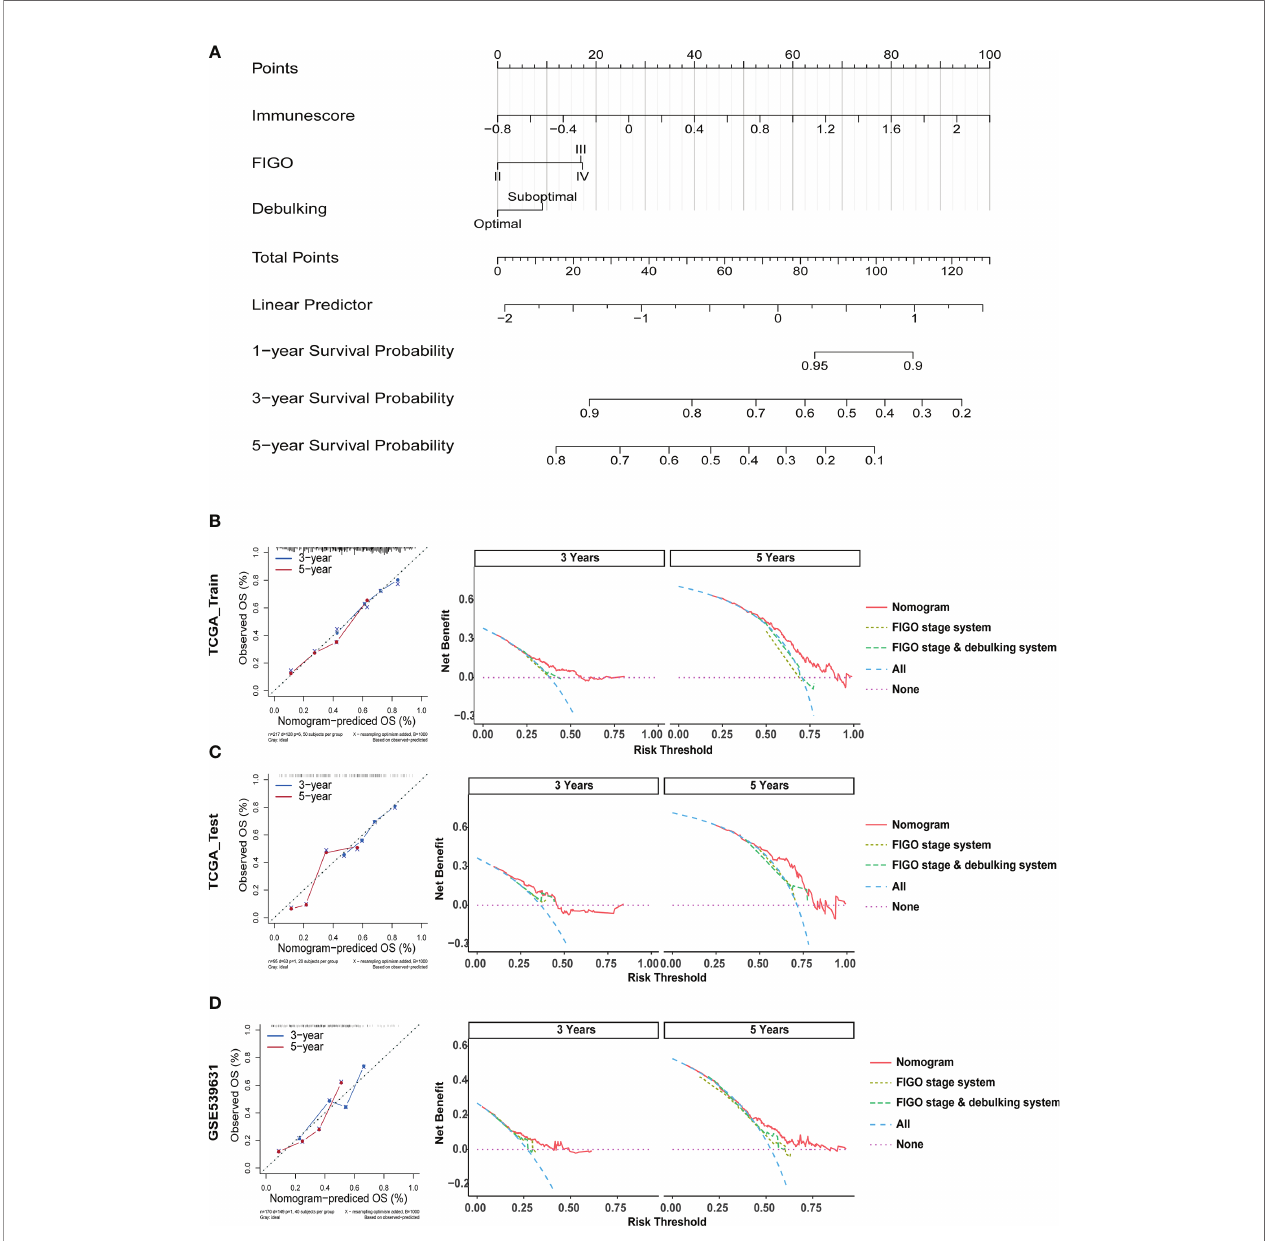
FIGURE 8 | Construction and Validation of a Nomogram for Survival Prediction of EOC Patients. (A) The nomogram was constructed in the training cohort for forecasting 1-, 3-, and 5-year survival of patients. (B) Calibration plots and decision curves for 3-, and 5-year survival prediction premised on the nomogram in the TCGA training cohort. (C) Calibration plots and decision curves for 3-, and 5-year survival prediction premised on the nomogram in the TCGA test cohort. (D) Calibration plots and decision curves for 3-, and 5-year survival prediction premised on the nomogram in the GSE53963